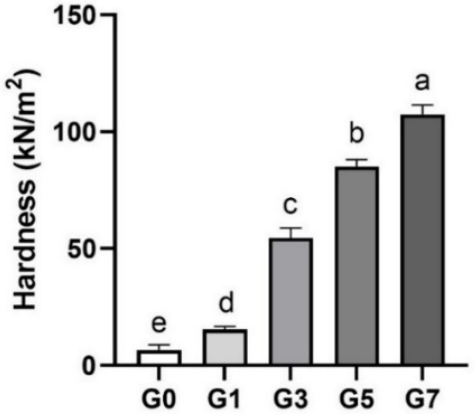
Figure 1. The hardness of abalone 3D print ink according to gelatin concentration (0–7%). Error bars represent the standard deviation, and different letters on the top of the column indicated a significant difference ( p < 0.05).